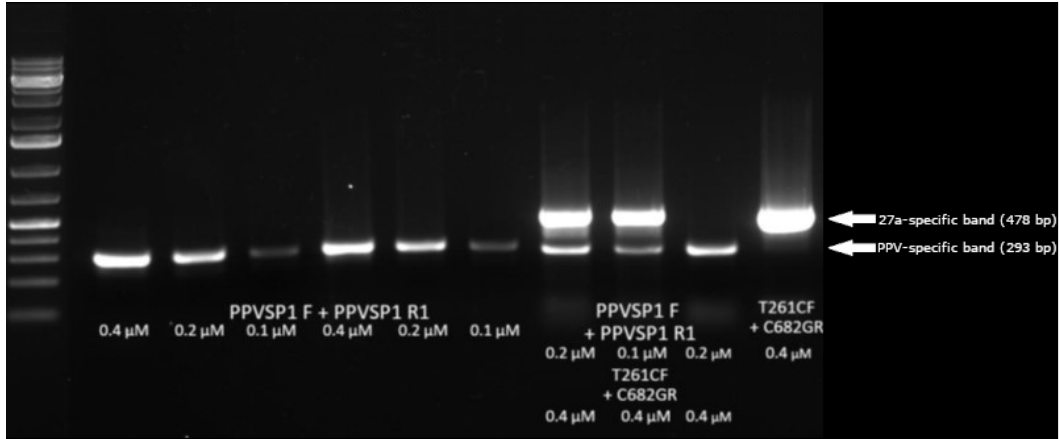
Figure 7. Combination of PPV and 27a-specific primer sets in a dual PCR. Lane 1, GeneRuler 1 kb+ ladder; Lane 2–7, Psps (PPVSP1F + PPVSP1R1 primers) alone in different concentrations with 27a and K22 (non-27a) templates; Lane 8–10, Dual PCR combining Psps and PS1 primer sets with 27a and K22 (non-27a) templates. Lane 11, PS1 primer set with 27a template. Primer concentrations are indicated on the lanes.